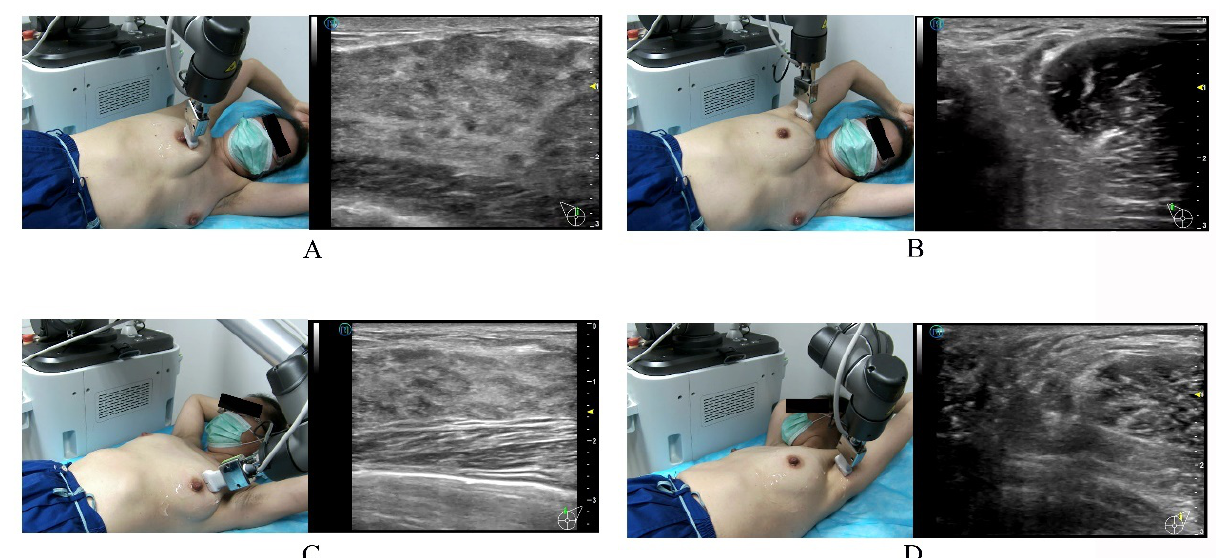
Figure 2. Illustration of the positions of the patient for 5G-based telerobotic breast ultrasound examination. When scanning the right breast ( A ) and axilla ( B ), the patient is placed in the left lateral position with the arms raised overhead. When scanning the left breast ( C ), the patient is placed in the supine position with the arms raised overhead. While scanning the left axilla ( D ), the patient is in the right lateral position with the arms raised overhead.